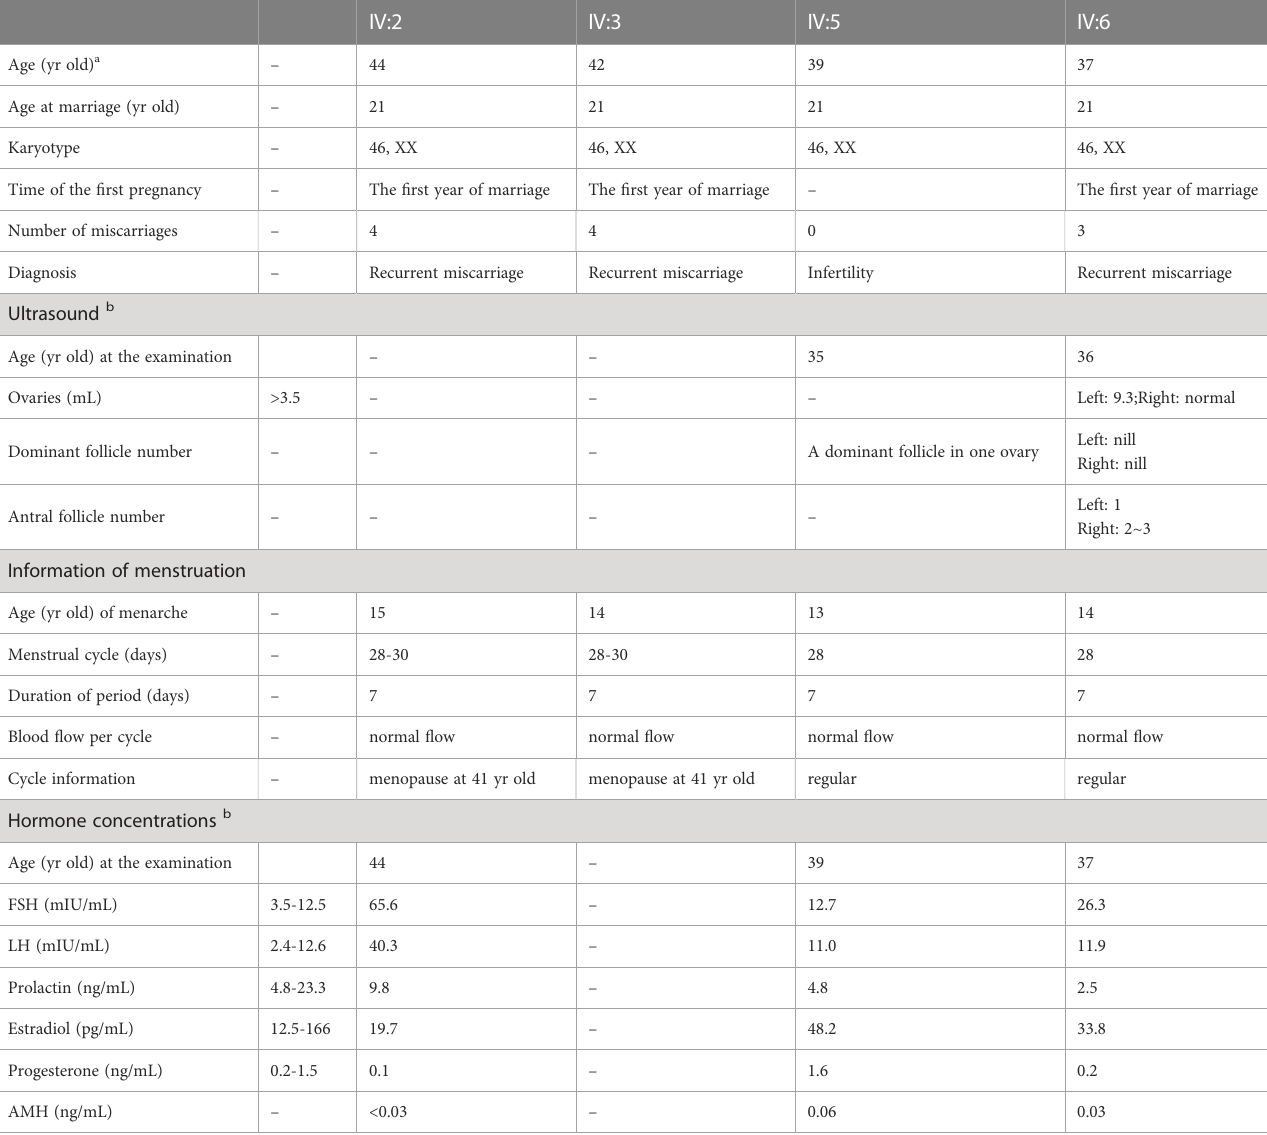
TABLE 1 Clinical characteristics of the female